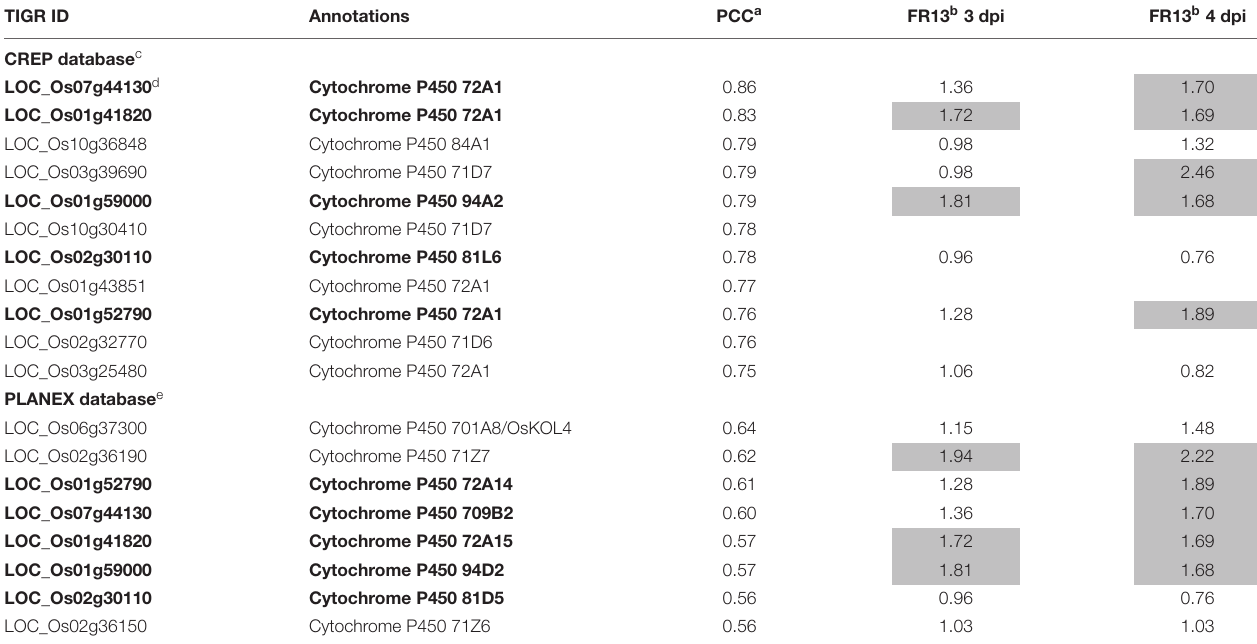
TABLE 3 | Cytochrome P450 genes co-expressed with ONAC066. TIGR